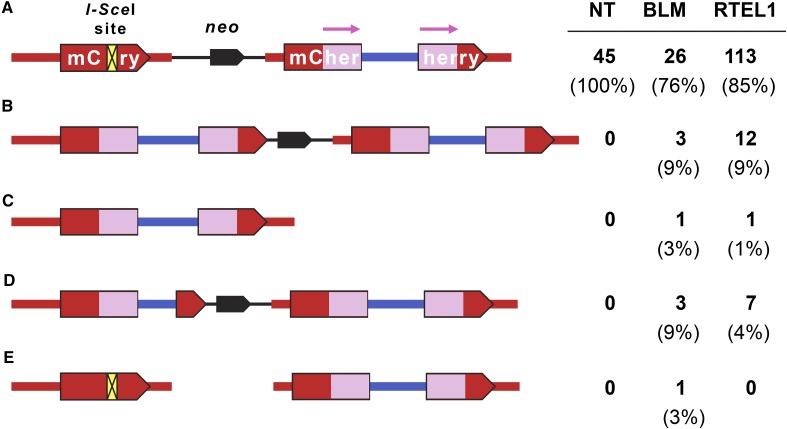
Structures of repair events in cells not expressing mCherry. Single cells not exhibiting red fluorescence were grown and then analyzed. (A) The starting construct, and the structure found in the majority of clones in each siRNA treatment group. (B) Copying of the entire template into the upstream mCherry I-SceI site. This might occur through long-tract SDSA (one synthesis cycle or several) or a dHJ intermediate (as in Figure 2D, center). (C) Copying of the entire template with loss of intervening sequences. This is proposed to occur when a dHJ intermediate is resolved in the crossover orientation, as in Figure 2D, bottom. (D) Copying of part of the template into the upstream mCherry site, as predicted from initiation of SDSA but completion of repair by end joining, as in Figure 2E. (E) Retention of the I-SceI site with loss of the neo and ori sequences.